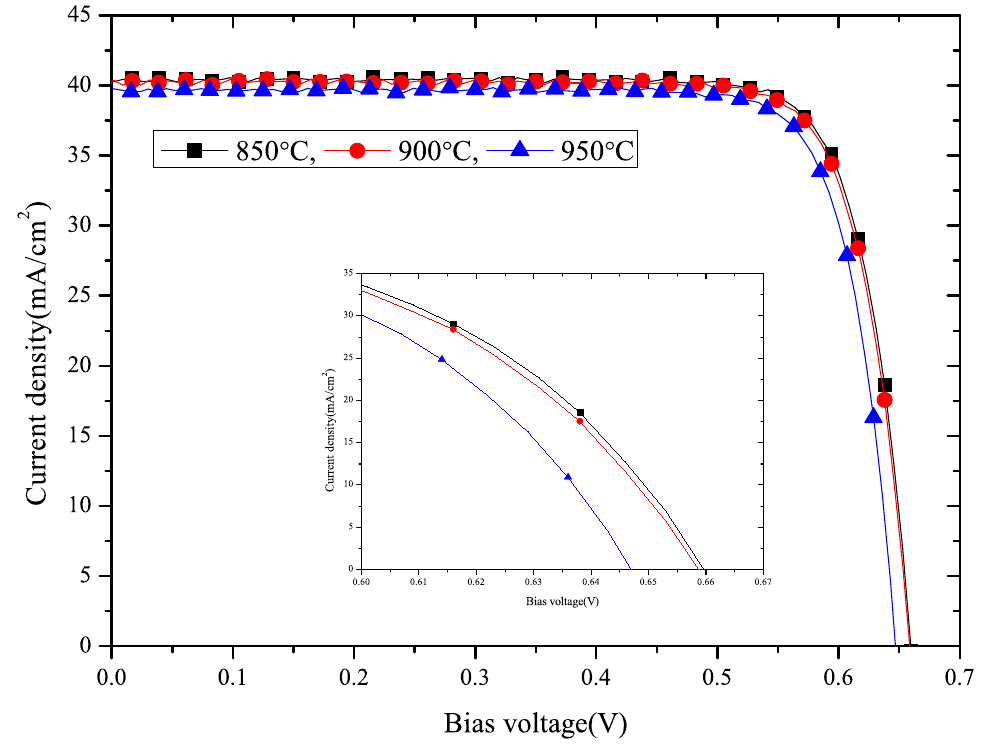
Figure 3. Light-biased current-voltage (LIV) results of the PERC solar cell depending on temperature